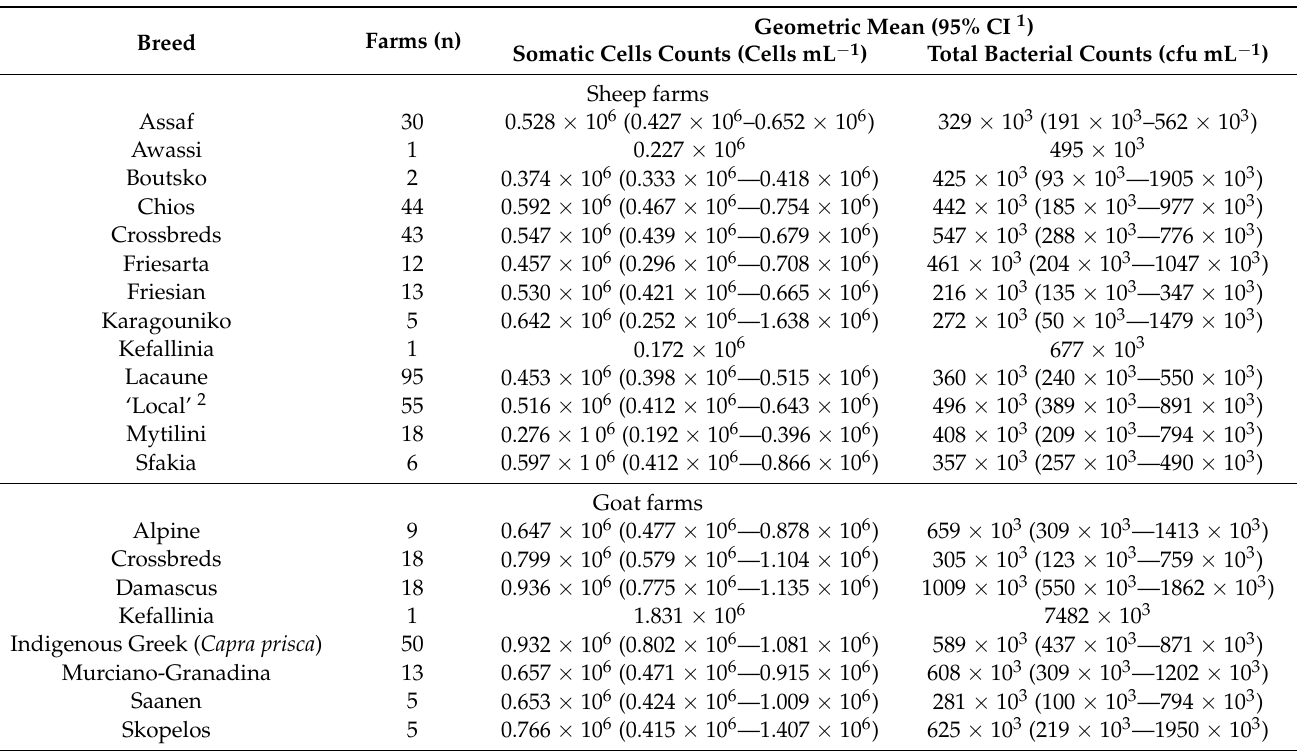
Table 1. Geometric mean somatic cell counts and total bacterial counts in bulk-tank milk in small ruminant farms in Greece according to animal breed in the